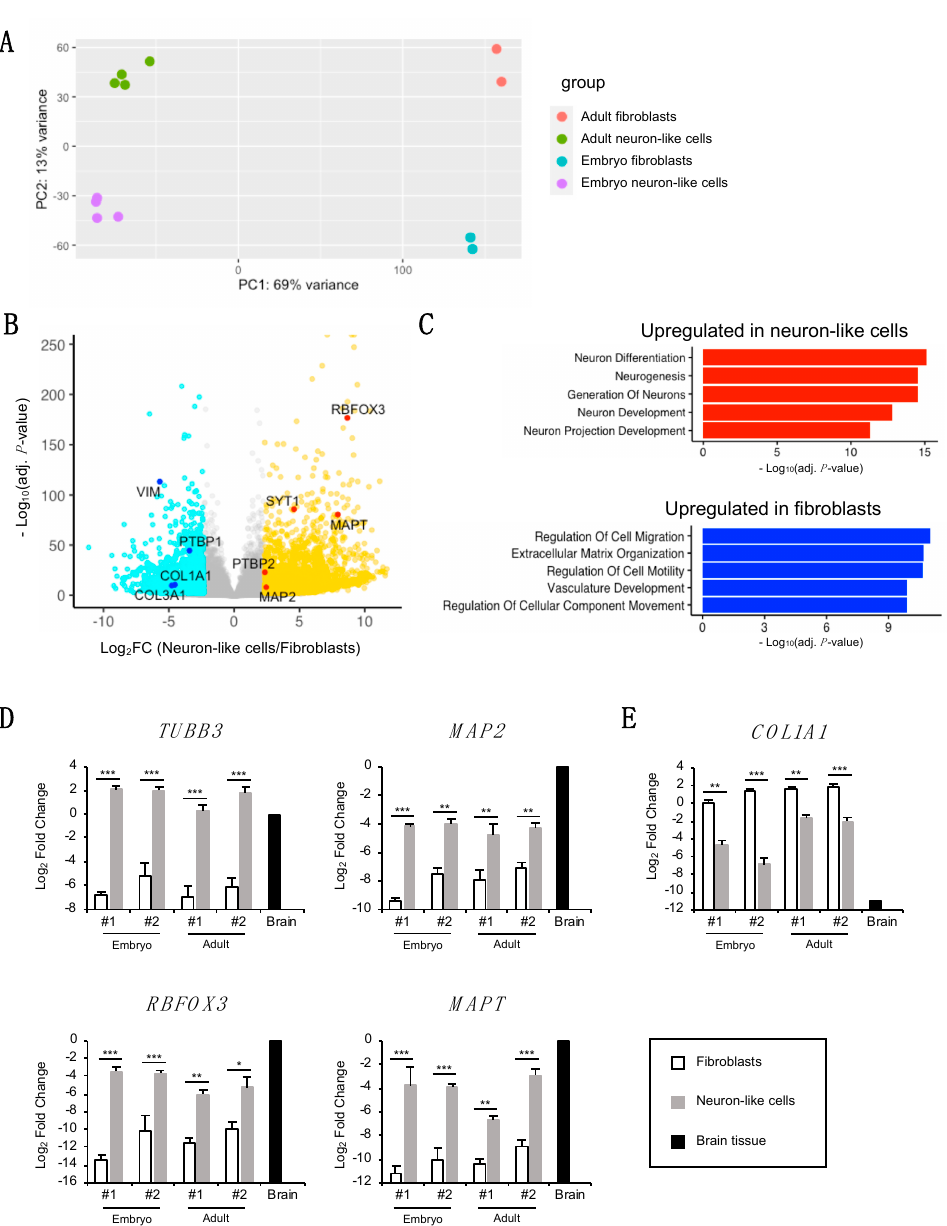
Figure 4. Transcriptomic analysis of neuron-like cells. ( A ) Principal component analysis of gene expression data between the original marmoset fibroblasts ( n = 1 experiment per animal) and neuron-like cells ( n = 2 independent experiments per animal). ( B ) Volcano plot representing neuronal and fibroblast marker genes differentially expressed between the original fibroblasts and the neuron-like cells. We identified differentially expressed genes, which are highlighted, with a cutoff of 0.01 for Benjamini-Hochberg adjusted p -values and a cutoff of 5 for the fold-change ratio. ( C ) Gene ontology terms associated with the genes upregulated in the neuron-like cells (red) and original fibroblasts (blue). ( D , E ) Quantitative PCR analysis of pan-neuronal markers and fibroblast marker genes (normalized to glyceraldehyde 3-phosphate dehydrogenase) in the original fibroblasts ( n ≥ 3 independent experiments per animal), neuron-like cells ( n ≥ 3 independent experiments per animal), and brain tissue (from one animal). The Y -axis represents the normalized log 2 fold-change values. Data are represented as the mean ± standard error of the mean. Differences between means were compared using one-way analysis of variance followed by a post hoc Tukey’s test. * p < 0.05; ** p < 0.01; *** p < 0.001. COL1A1, collagen type I alpha 1 chain; COL3A1, collagen type III alpha 1 chain; MAP2, microtubule-associated protein 2; MAPT, microtubule-associated protein tau; RBFOX3, RNA binding fox-1 homolog 3; PTBP1/2, polypyrimidine tract-binding protein 1/2; SYT1, synaptotagmin 1; TUBB3, class III beta-tubulin; VIM,